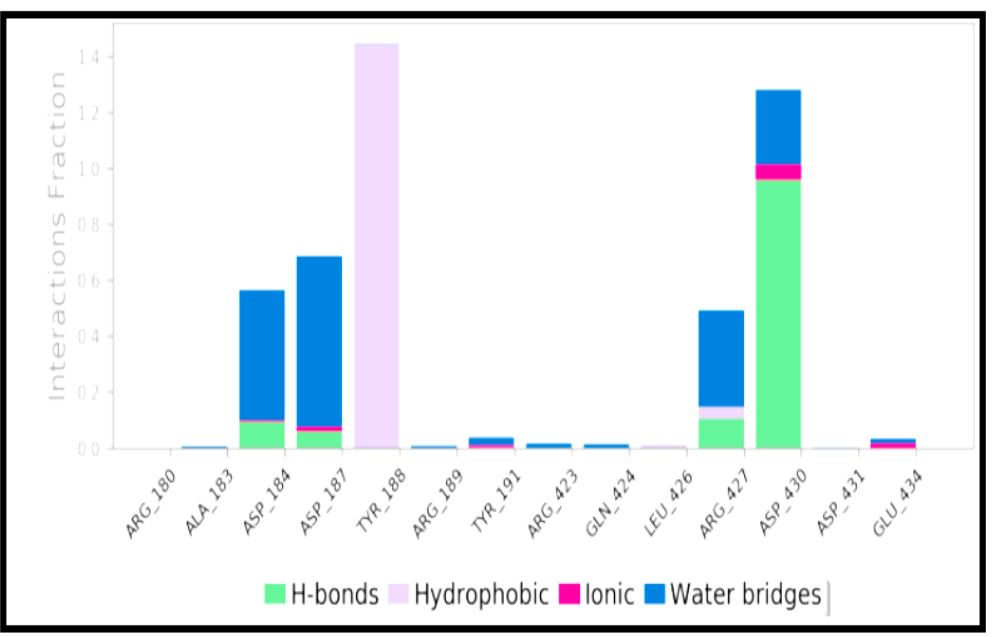
Figure 5. Bar chart displaying the aminoacid contributing to the ligand interaction.